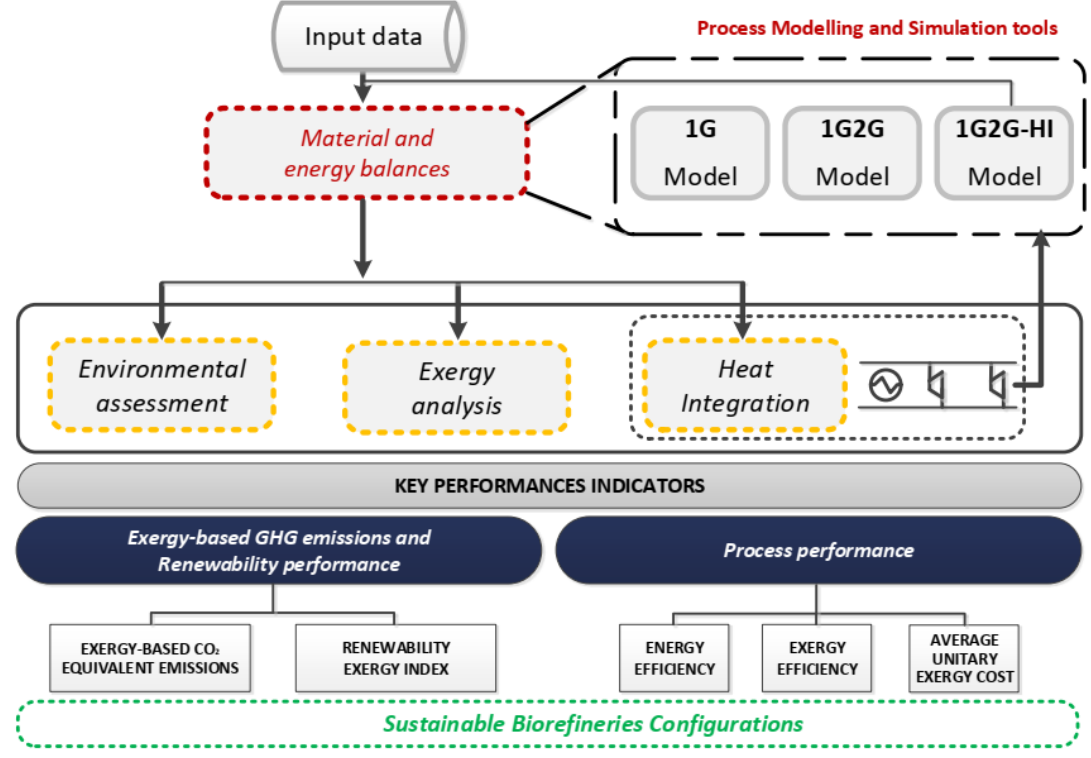
Figure 2. Flow diagram of the conceptual process design and assessment methodologies.